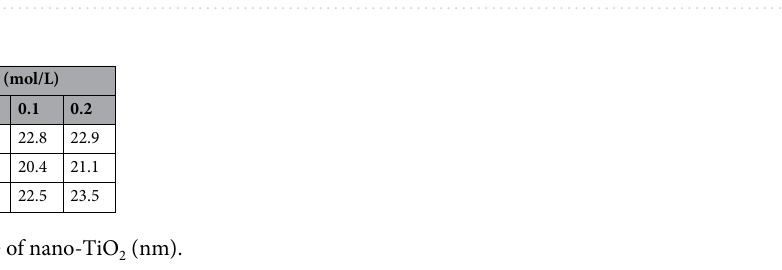
Figure 2. XRD patterns of the prepared DE/nano-TiO 2 after calcination at 700 °C for 2 h (open circle: Anatase; cross symbol: Rutile).